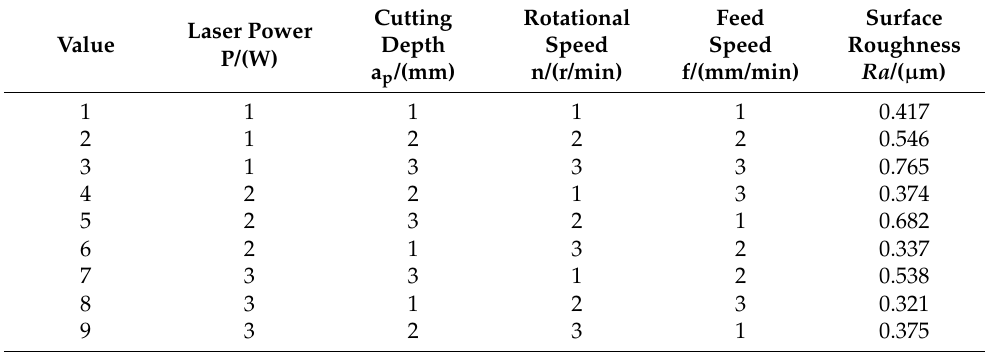
Table 4. Orthogonal experimental